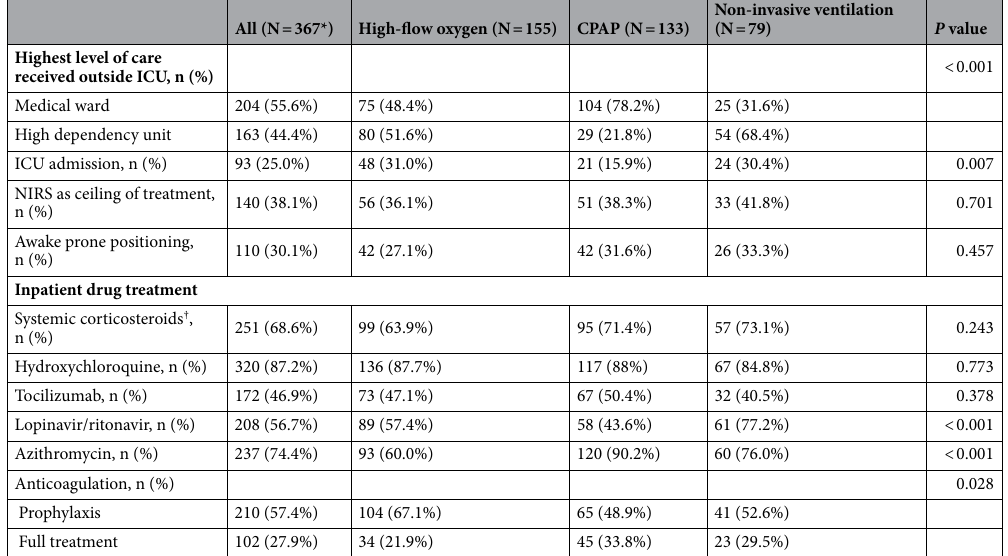
Table 3. Inpatient characteristics and treatments according to non-invasive respiratory support group. P-value from Chi 2 test. *Anticoagulation had 1 missing value. † Systemic corticosteroids included prednisone (n = 6), methylprednisolone (n = 223), dexamethasone (n = 21) and hydrocortisone (n =